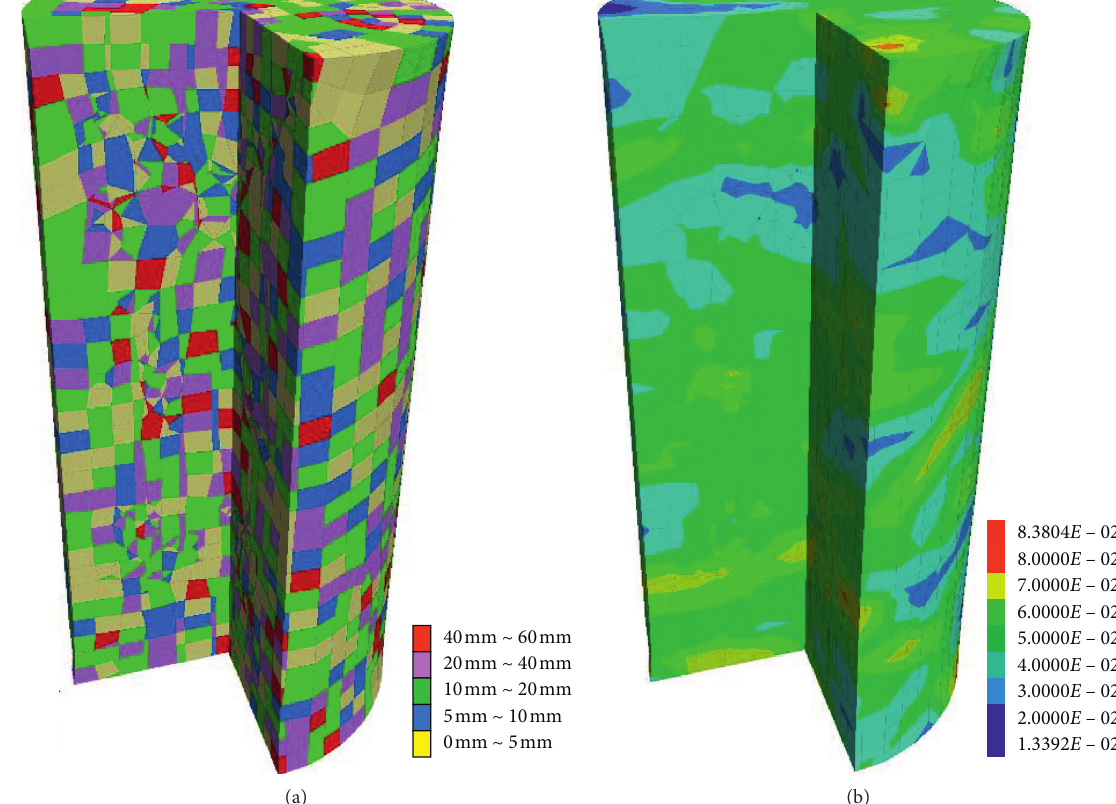
Figure 17: The distribution of grain groups and the cloud graph of shear strain increment: (a) the distribution of grain groups; (b) the cloud graph of shear strain